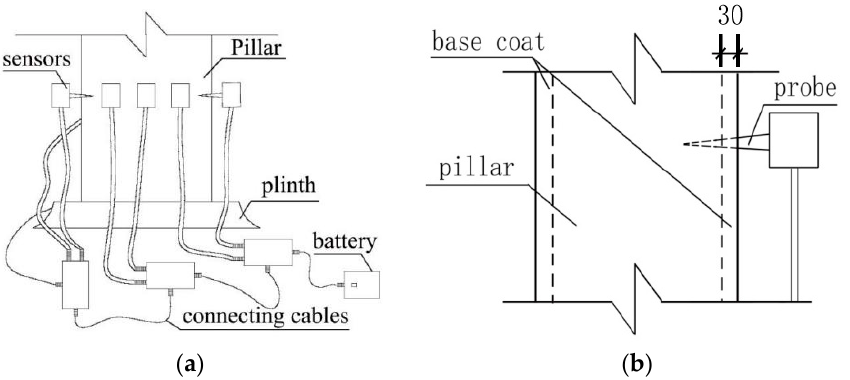
Figure 3. Schematic layout of the wood component testing process using the stress wave sensor: ( a ) Layout of stress wave sensors; ( b ) Penetration depth of stress wave sensor.